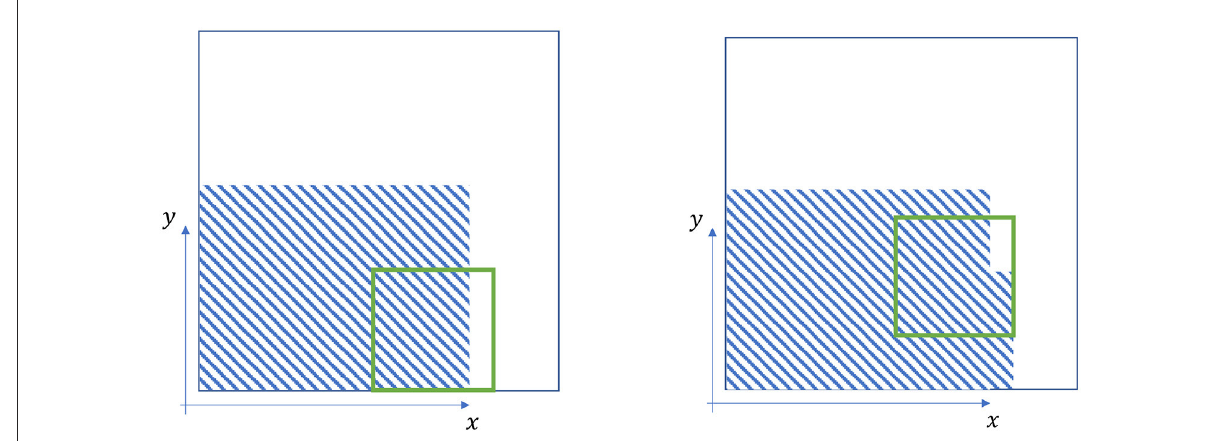
FIGURE3 Examples of overlap between a solution candidate (shaded), a new window